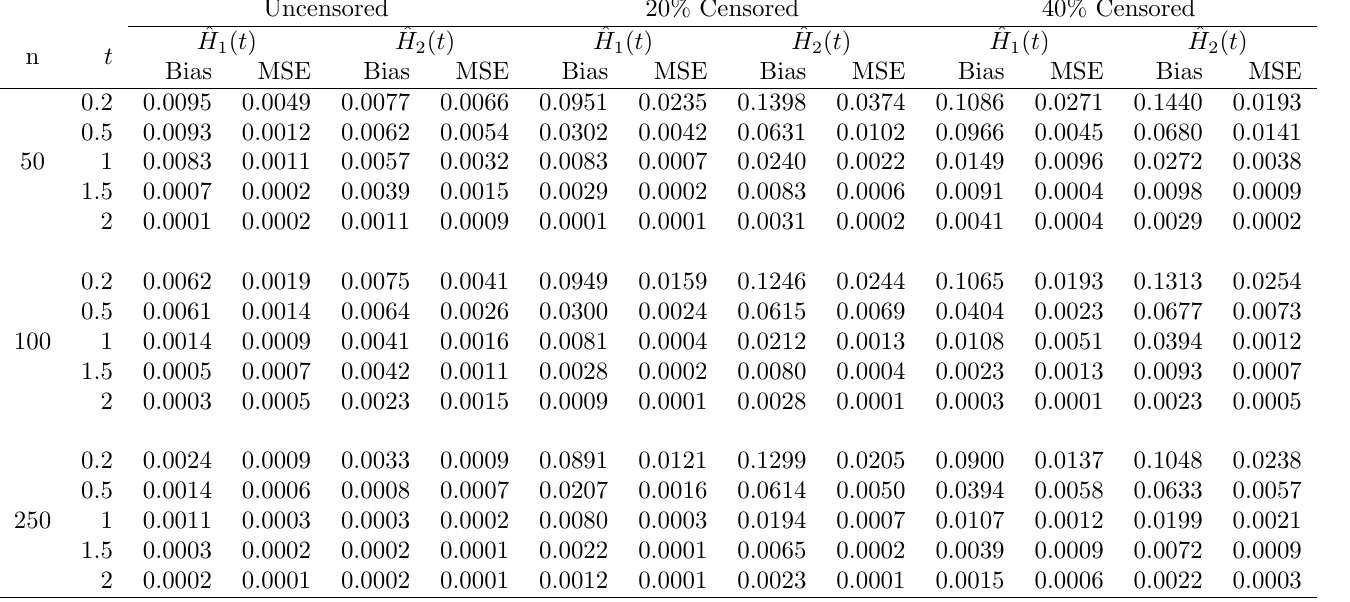
Bias and MSE of the estimates of H 1 ( t ) and H 2 ( t ) for a = 1 . 5 , ϕ = 0 . 4 and λ =